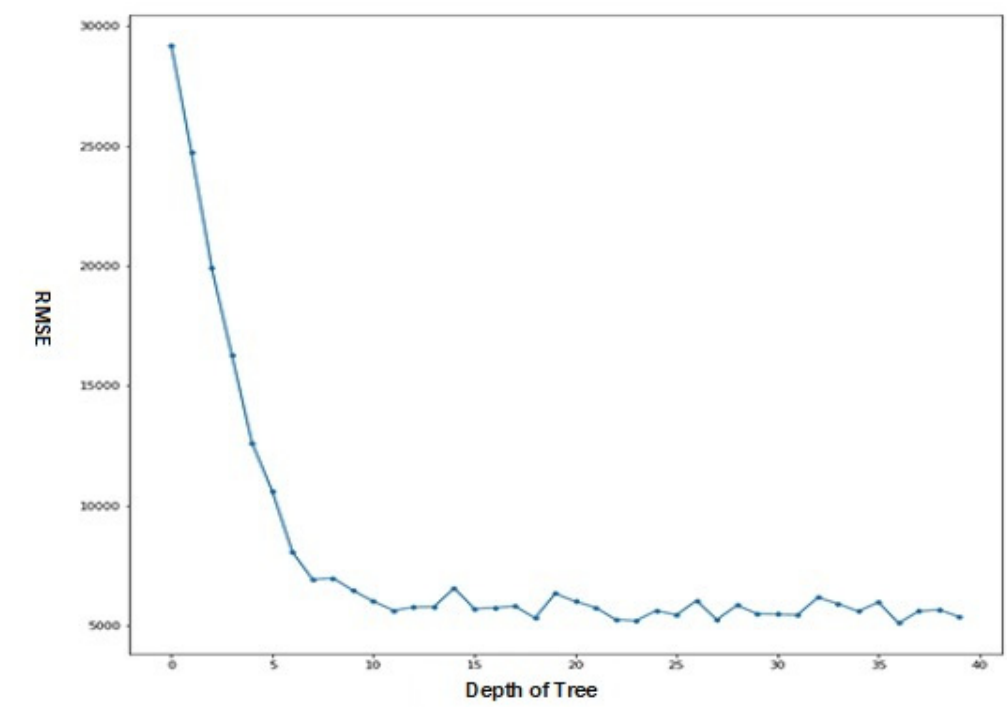
Figure 6. Tree depth versus the RMSE score of the decision tree model.